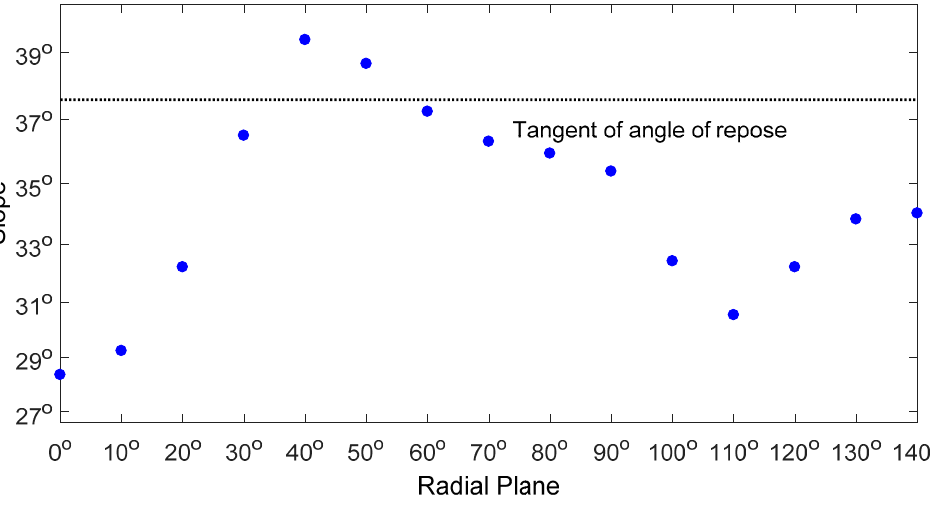
Figure 10. Average slope of radial profiles during the development phase.